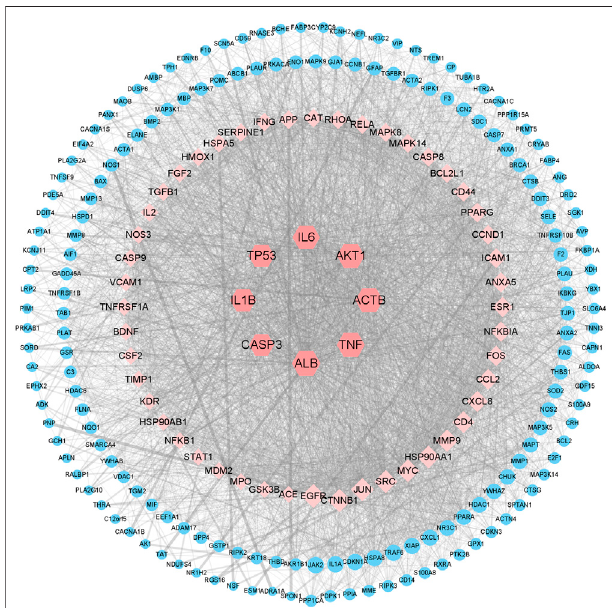
FIGURE 4 | Network pharmacology revealed the targets characteristics of colchicine with therapeutic potential for MIRI. A protein network of known targets of colchicine with therapeutic potential for MIRI was generated by